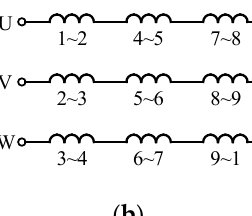
Figure 5. Slot vector diagrams. ( a ) 4-pole-pair number. ( b ) 12-pole-pair number.